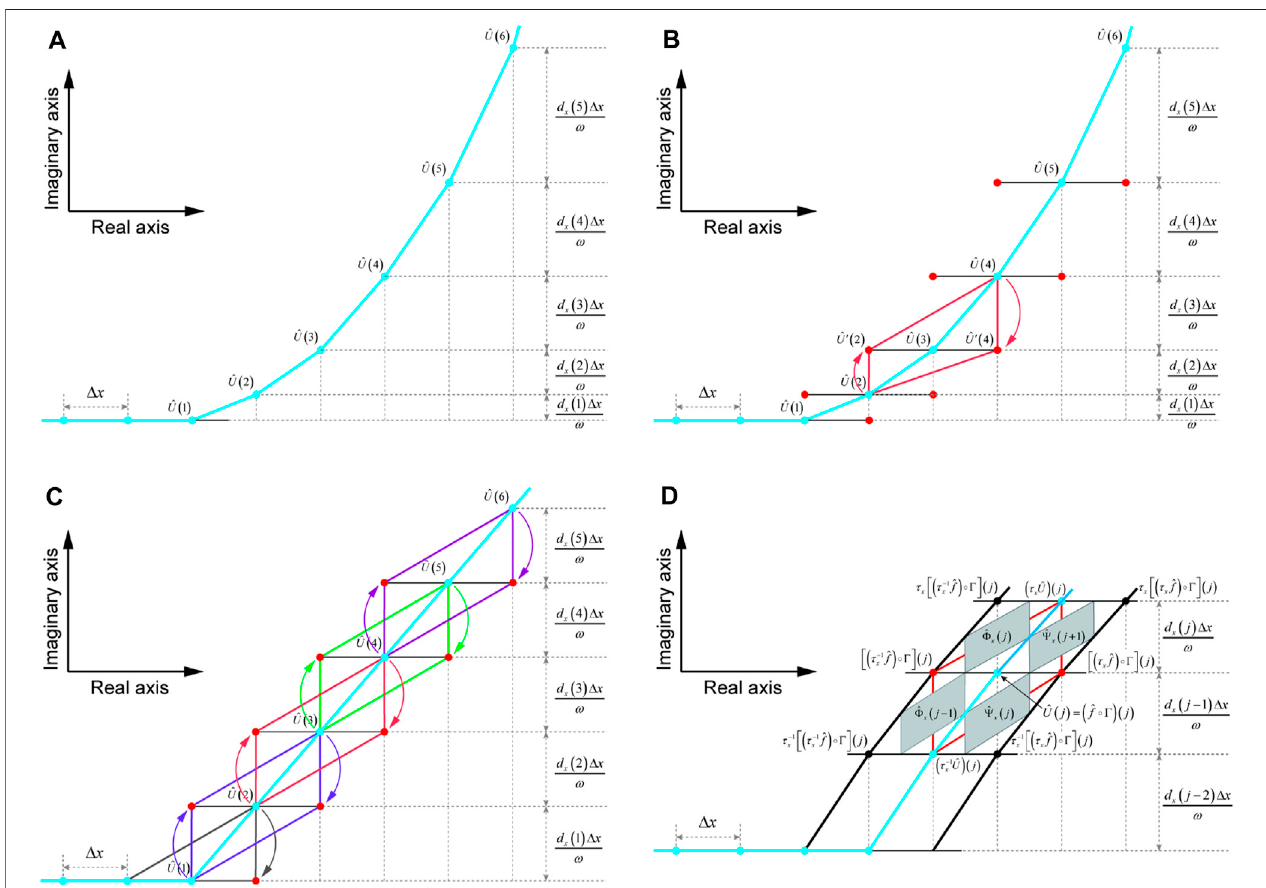
FIGURE 2 | Sketch map of the stretching path for the PML in the complex coordinate after discretization and sketch map of the projection method using discrete complexanalysis. (A) The discrete stretching path for thePML in thecomplexcoordinate using gradually increasing attenuation coef fi cients. (B) Thequadrilateral for the projectionusing discrete complexanalysisforthe discrete path in (A) . (C) The discrete stretching path forthePML inthecomplexcoordinateusing constant attenuation coef fi cients.Thequadrilateralsofdifferentcolorsrepresenttheprojectionquadrilateralsofthe2 nd -orderFDoperatorcorrespondingtotherespectivecenterpoints. (D) Sketch map the projection method of the quadrilateral corresponding to ^ U ( i ) using discrete complex analysis. Symbol + represents compound function operation (e.g., ^ f + Γ ( x ) (cid:1) ^ f [ Γ ( x )] ) and ^ f + Γ represents the stretching path of PML. τ x and τ − 1 x are the positive and negative shift operators, respectively.